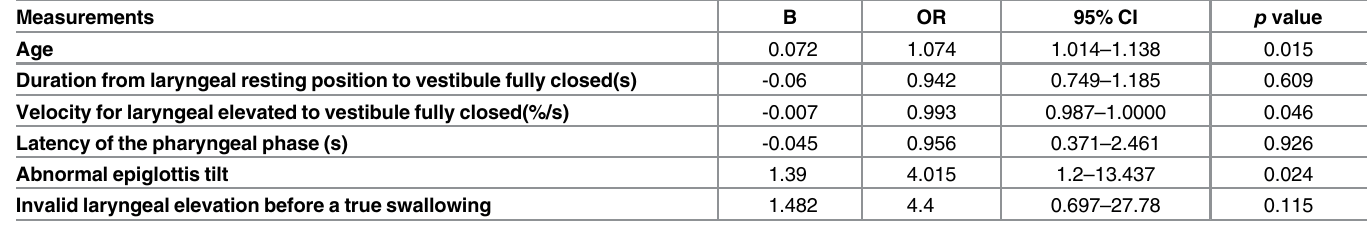
Invalid laryngeal elevation before a true